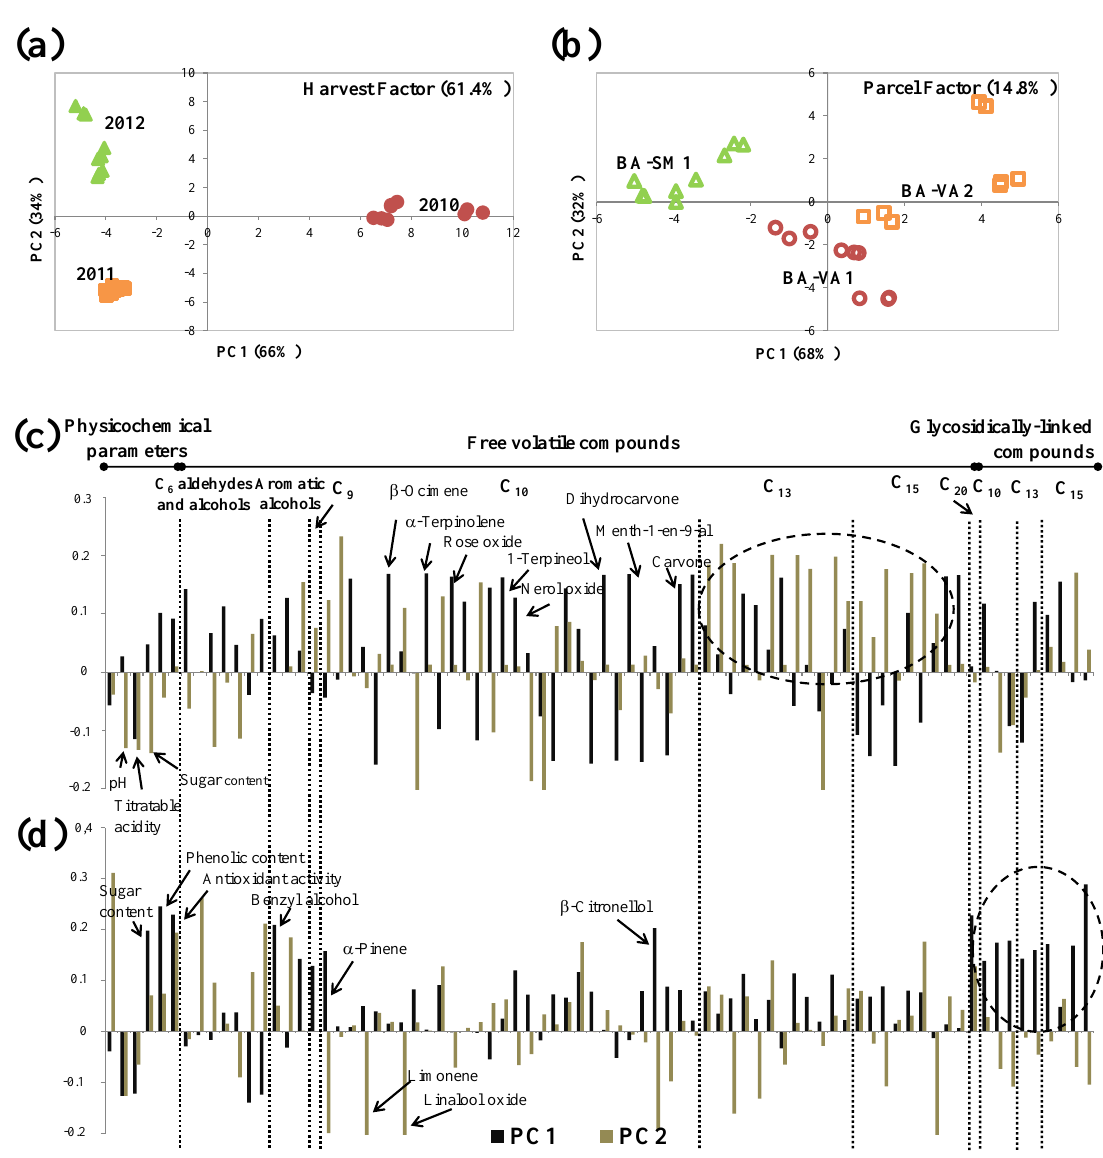
Figure 7. ASCA scores plot for ( a ) harvest and ( b ) parcel factors, and the corresponding variable loadings plot ( c , d ), respectively, obtained for Baga, at technological maturity (significance test reported on Table 4). Each variable is normalized separately by dividing by its standard deviation value.